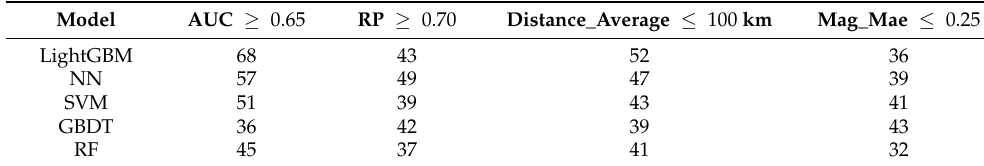
Table 1. The results of non-time series models.